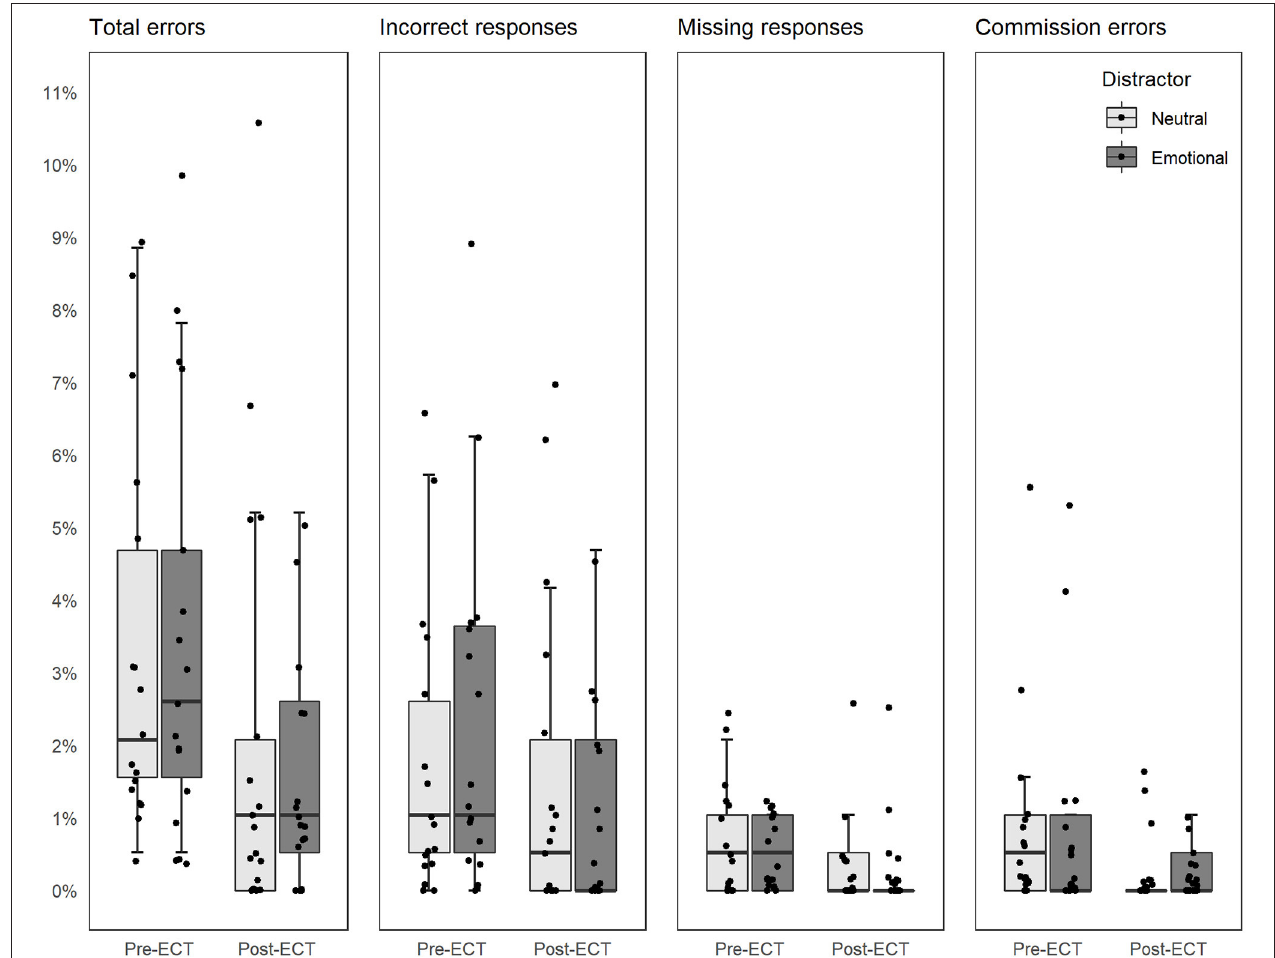
FIGURE 3 | Error rates in the context of threat related and neutral distractor pre- and post-ECT. All figures share the Y-axis on the left. Dots indicate individual subjects and have been jittered to separate individual subjects.